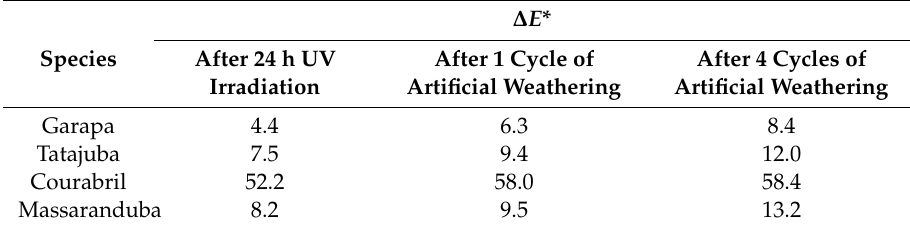
Table 2. Overall colour change ( ∆ E *) during exposure.